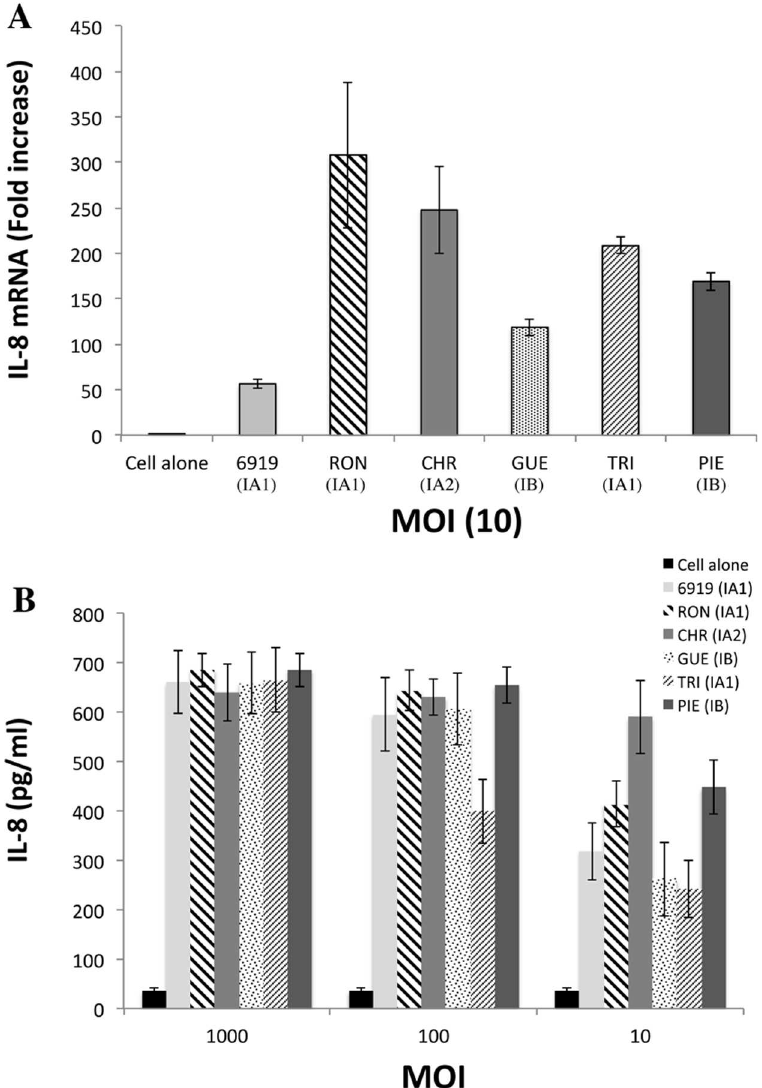
Fig 1. Induction of CXCL8 production in kerationocytes stimulated with whole P . acnes bacteria. HaCaT cells were incubatedfor 18 h with whole P . acnes bacteria (6919, RON, CHR, GUE, TRI, PIE, Table 1) at a MOI of 10 (A) and at MOI of 10, 100, 1000 (B). Total RNA was extracted and CXCL8 mRNA levels were determined by real-time RT-PCR and comparedthose of GAPDH mRNA (used as the control). The difference is expressed as a fold-change. CXCL8 productionwas analyzedby ELISA on culture supernatants. Control experiments were run with unstimulated cells. The data are presented as the mean ± standarddeviationof three independent experiments. Statistical significanceis indicatedby * P (cid:20) 0.05, ** P (cid:20) 0.01, *** P (cid:20) 0.001, **** P (cid:20)